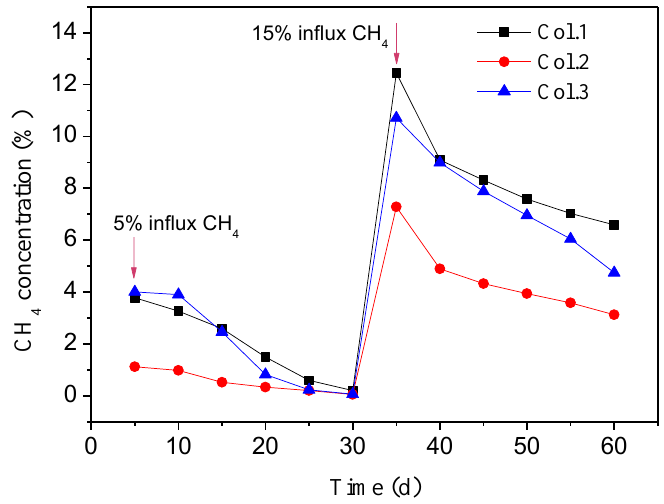
Figure 3. CH 4 concentration changes over time in the columns.